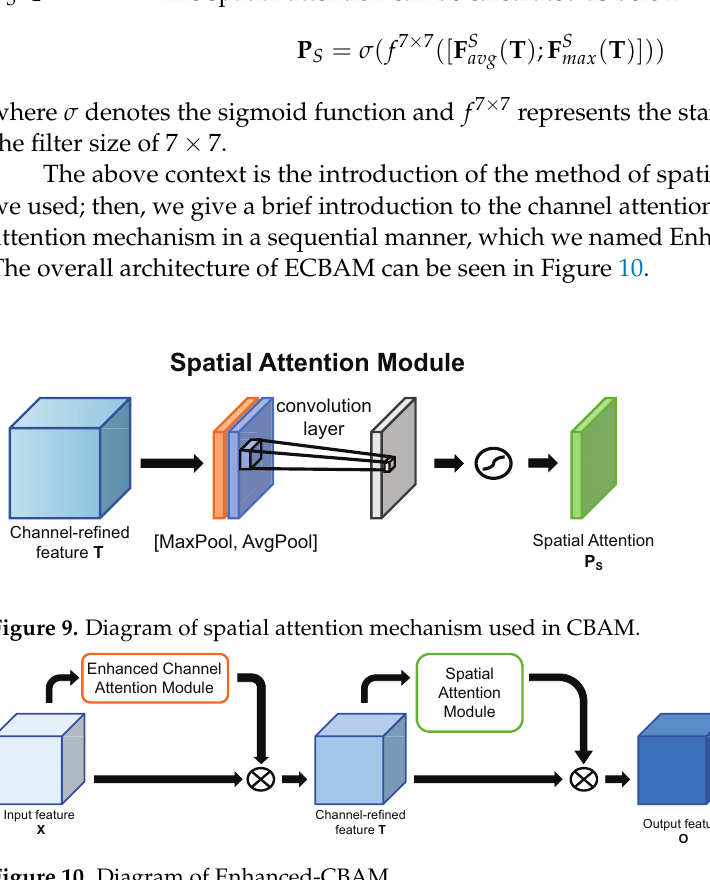
Figure 10. Diagram of